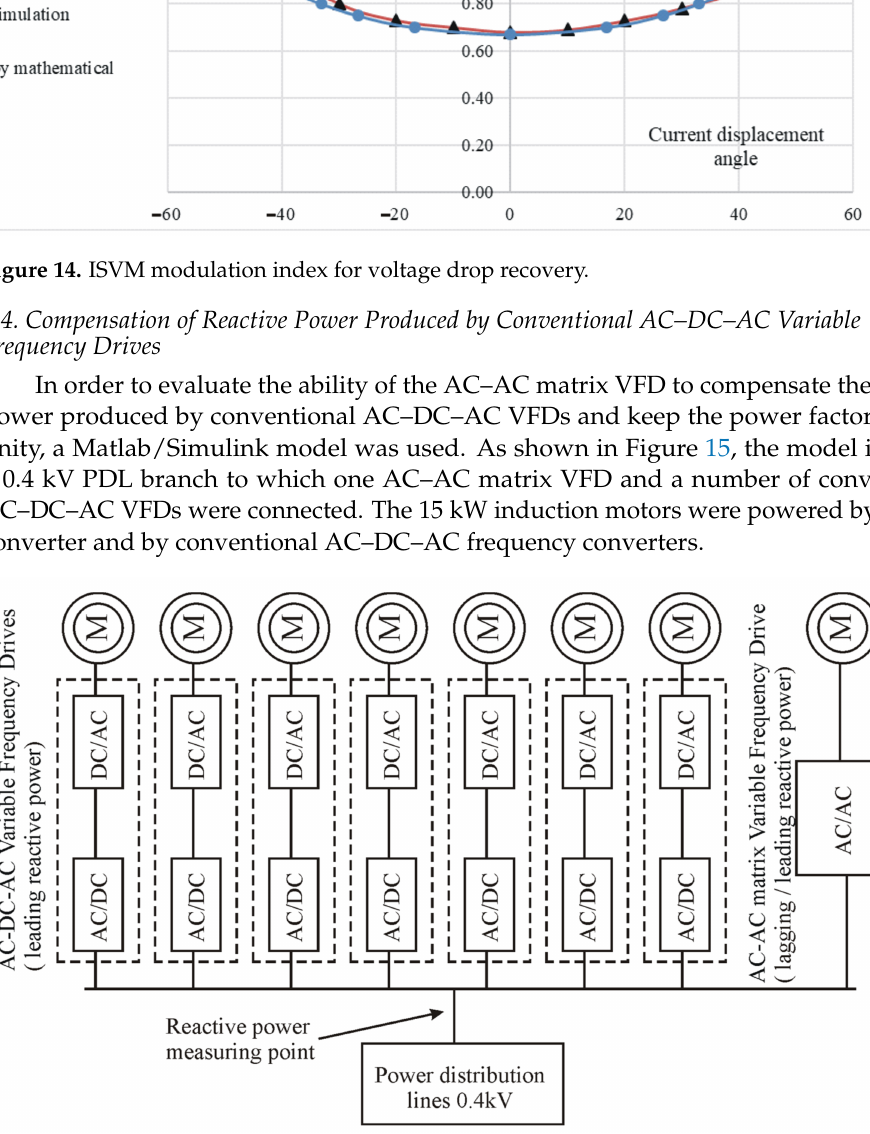
Figure 15. The researched system for conventional AC–DC–AC VFD reactive power